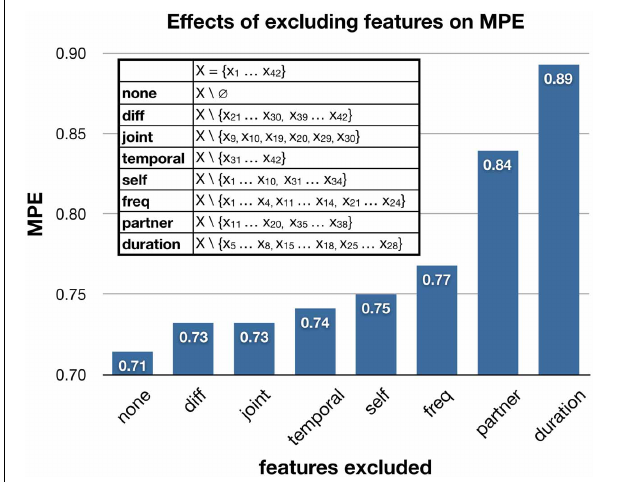
FIGURE 5 | The effects of excluding categories of features on the trust model’s mean prediction error. The legend lists the exact features of a category that were excluded, and their descriptions can be found in Tables 1 , 4